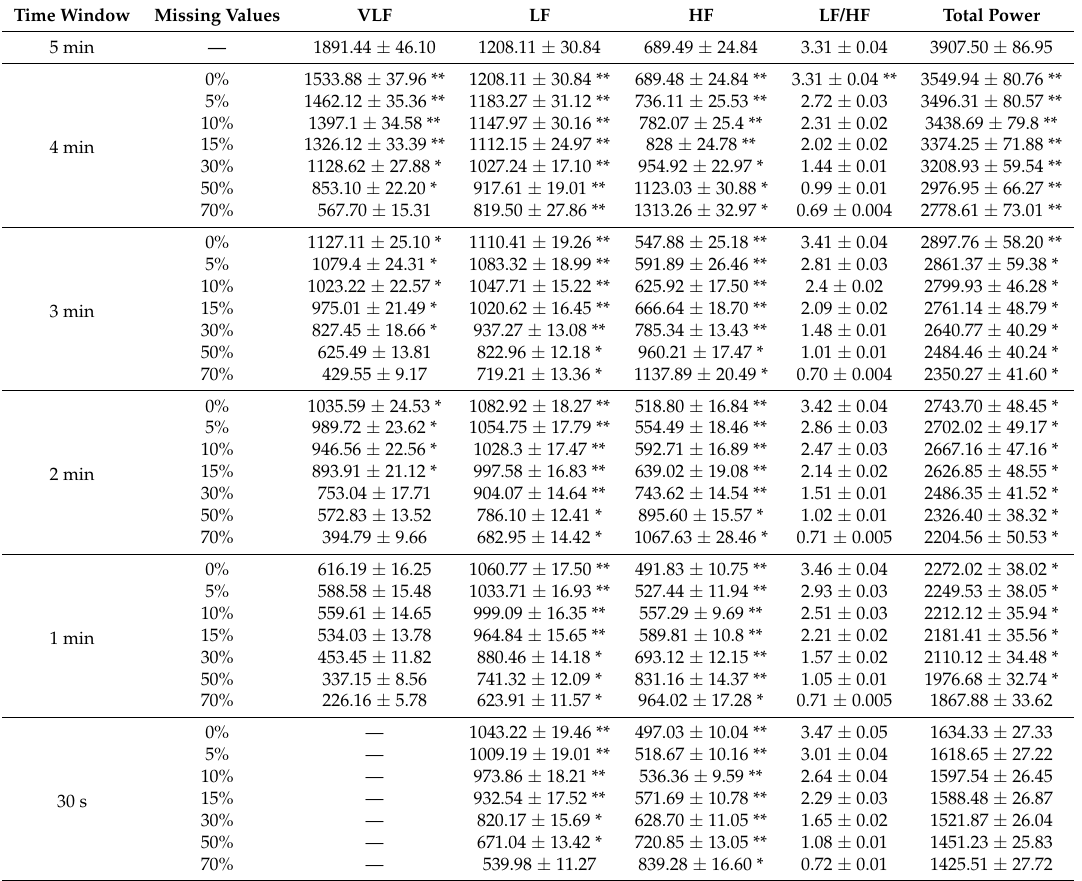
Table 4. Descriptive statistics (mean ± standard error of the mean) of VLF, LF, HF, LF/HF , and Total power of the power spectrum density for all of the time window and missing values. The statistical analysis is focused to compare 5 min HRV parameters to ultra-short ones. ** and * refer to the trivial and small ES of ultra-short HRV features compared to 5 min ones,